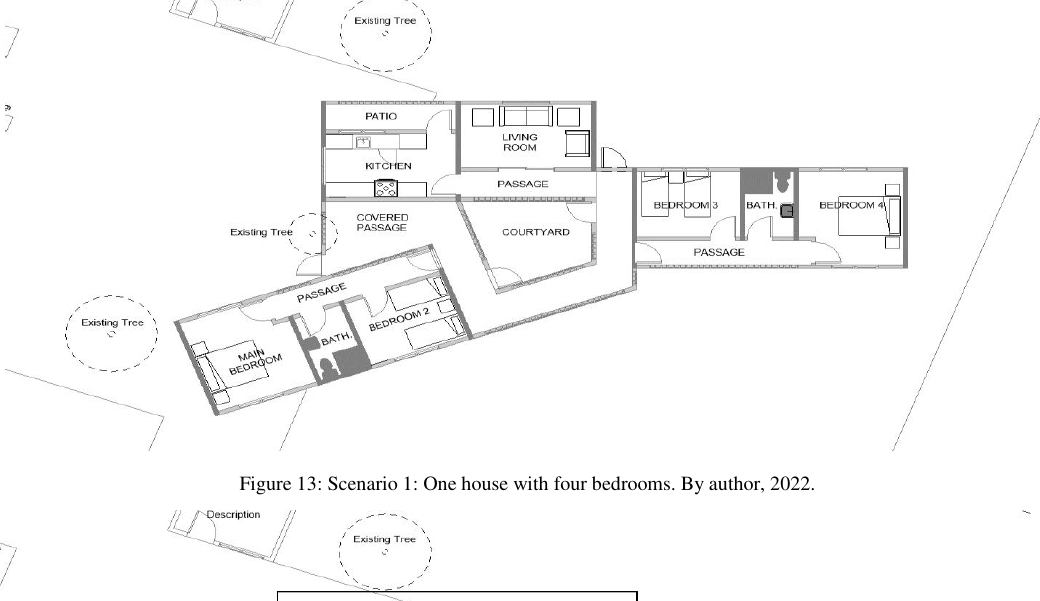
Figure 13: Scenario 1: One house with four bedrooms. By author, 2022.